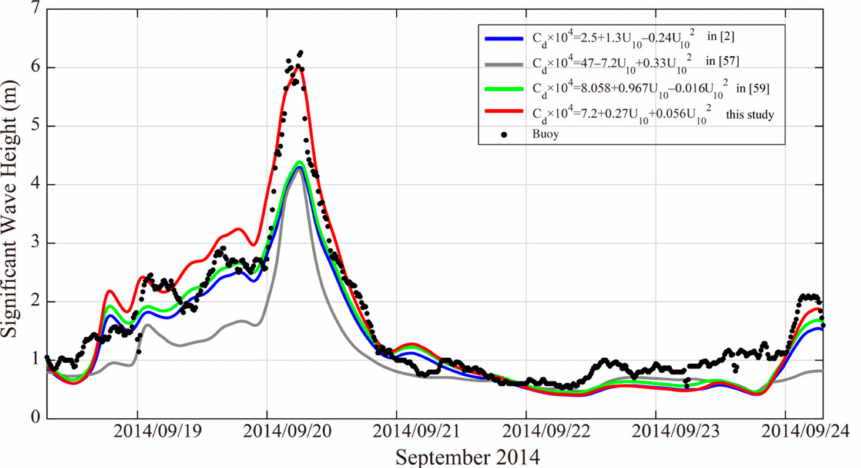
Figure 8. The comparisons of the WW3-simulated H s using the models adapted from [2] (blue line), [57] (gray line), [59] (green line), and this study (red line) with the measurements from the buoy